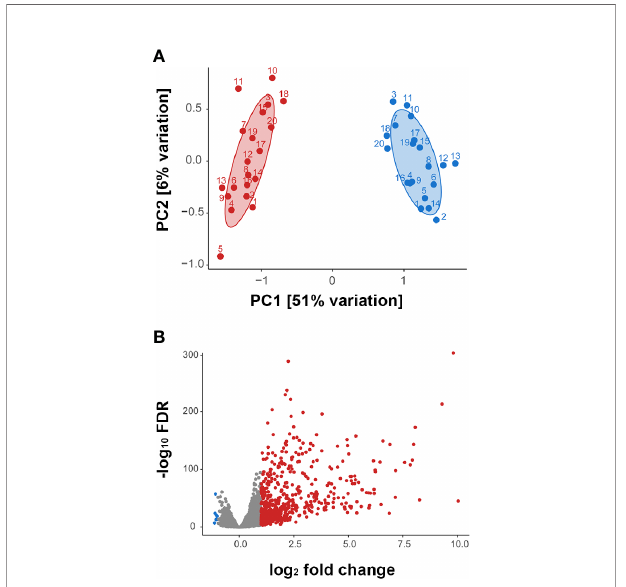
FIGURE 2 | (A) Multidimensional scaling plots showing global gene expression in ZIKV-infected (red) and uninfected (blue) human iris pigment epithelial cell isolates. Numbers indicate the 20 individual donors from whose eyes each isolate was generated. PC = principal component. (B) Volcano plot displaying differentially expressed genes between ZIKV-infected and uninfected human iris pigment epithelial cells, based on normalized counts per million (false discovery rate < 0.05 and fold change > 2). Red dots indicate signi fi cantly upregulated transcripts, and blue dots indicate signi fi cantly downregulated